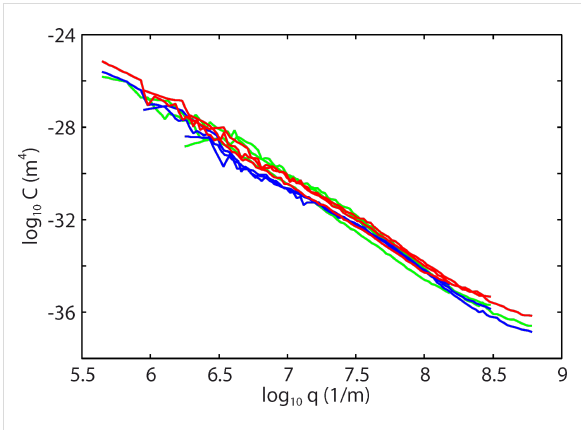
Figure 4: The power spectra as a function of the wave vector (log 10 –log 10 scale), based on AFM topography data (green lines). The red lines are for dry skin, the blue lines for wet skin (calculated without AFM measurements).